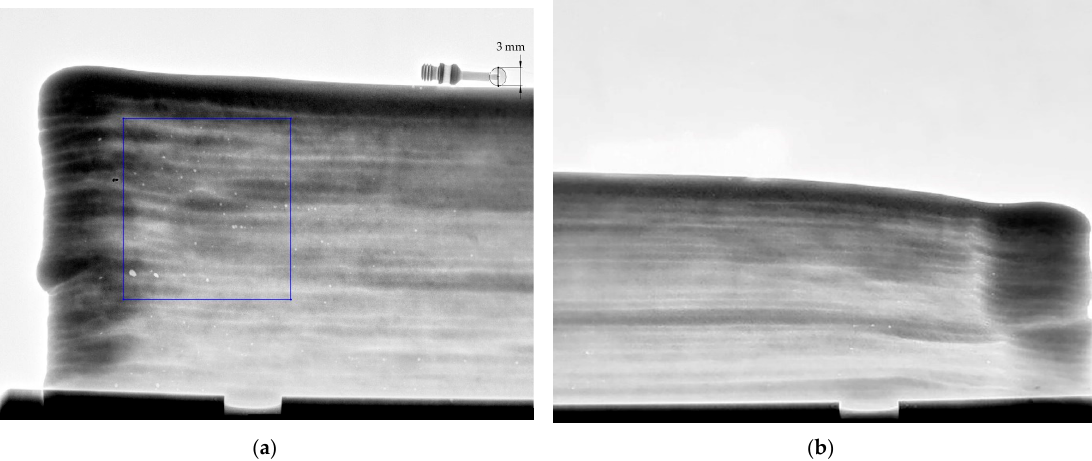
Figure 12. Defect volume of distribution of hot-wire plasma welding: ( a ) front area; ( b ) back area; scale 21:1 mm.